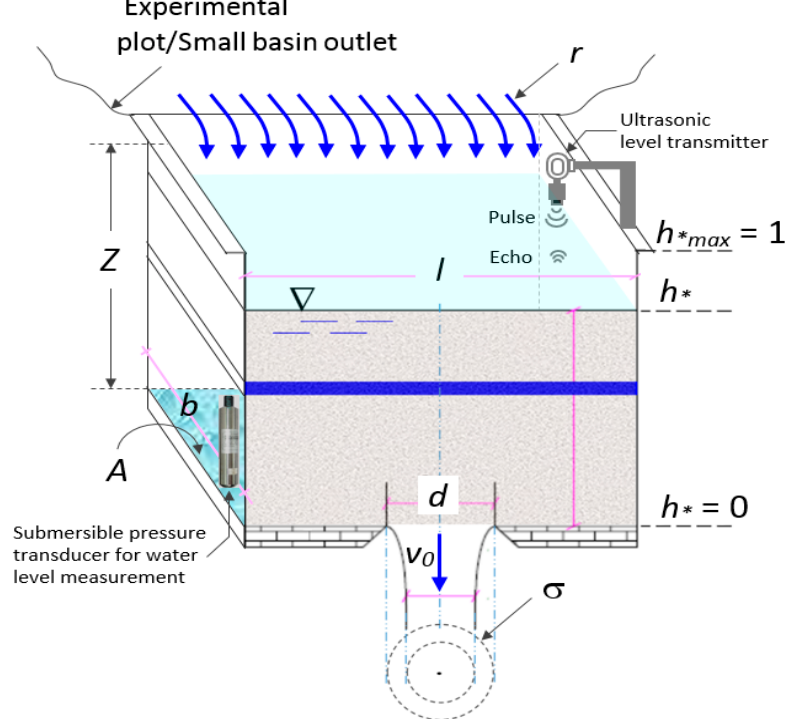
Figure 3. Three-dimensional (3D) view of the non-linear water tank where a hole is made at its bottom. Front of the figure refers to the section in the middle of the tank where the hole is made. Two options for water level measurements (submersible and ultrasonic probe) are